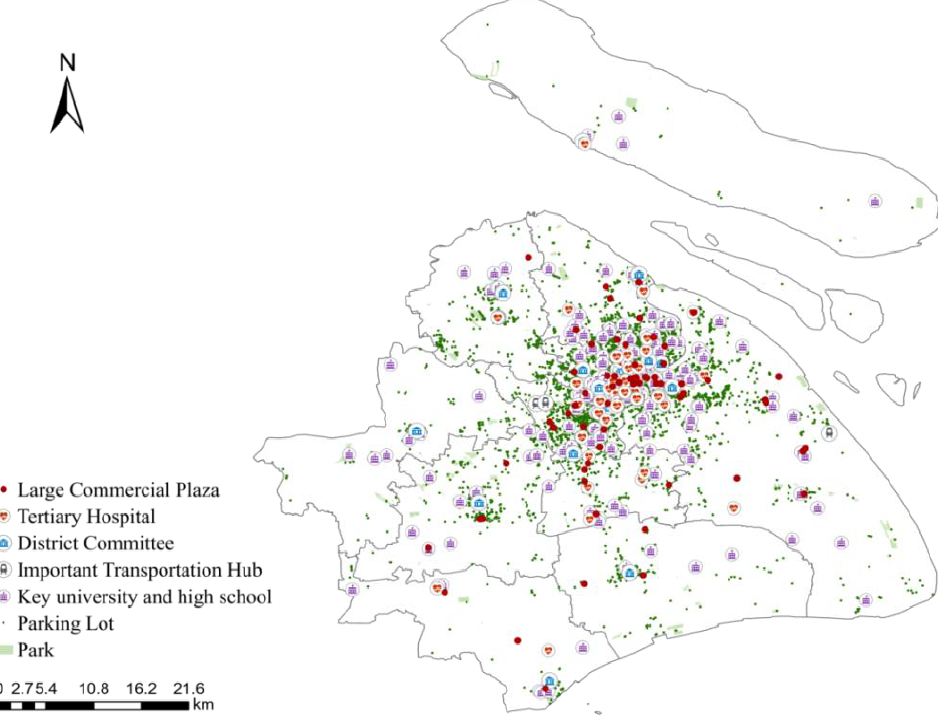
Figure 2. Distribution of traffic accessibility indicators in Shanghai.